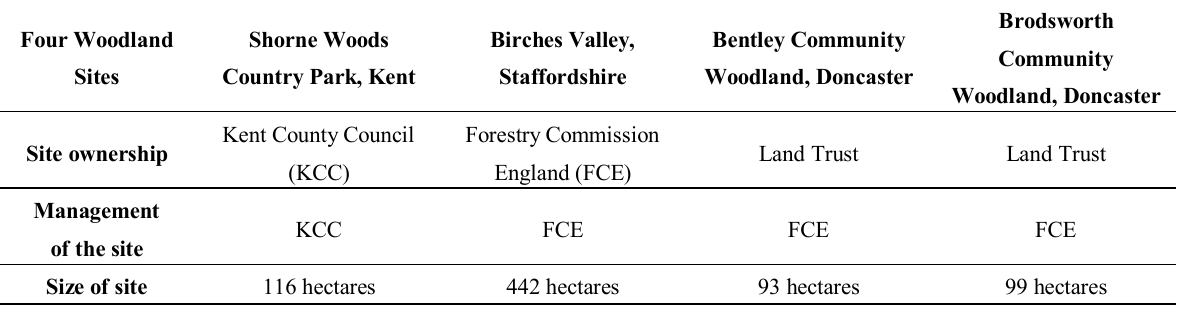
Table 1. Details of the four woodland sites in